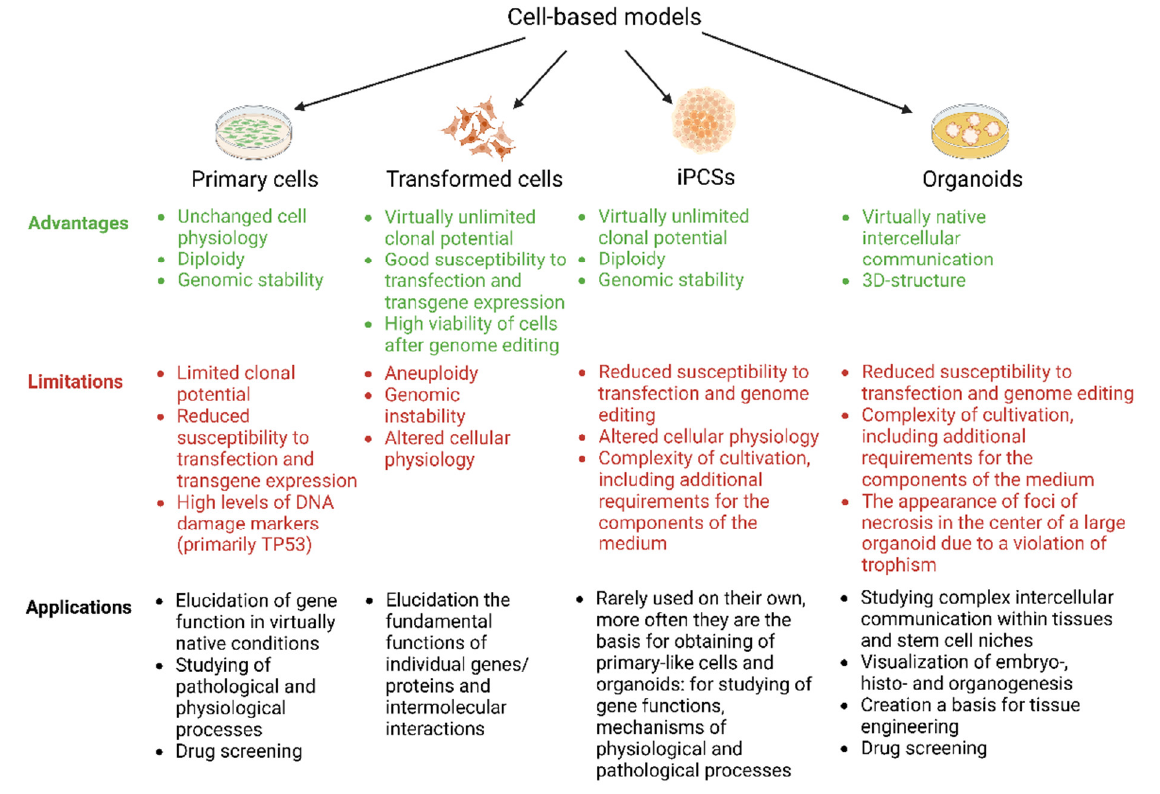
Figure 1. Cell-based models: advantages, limitations, and potential applications. Created with Bio- Render.com.